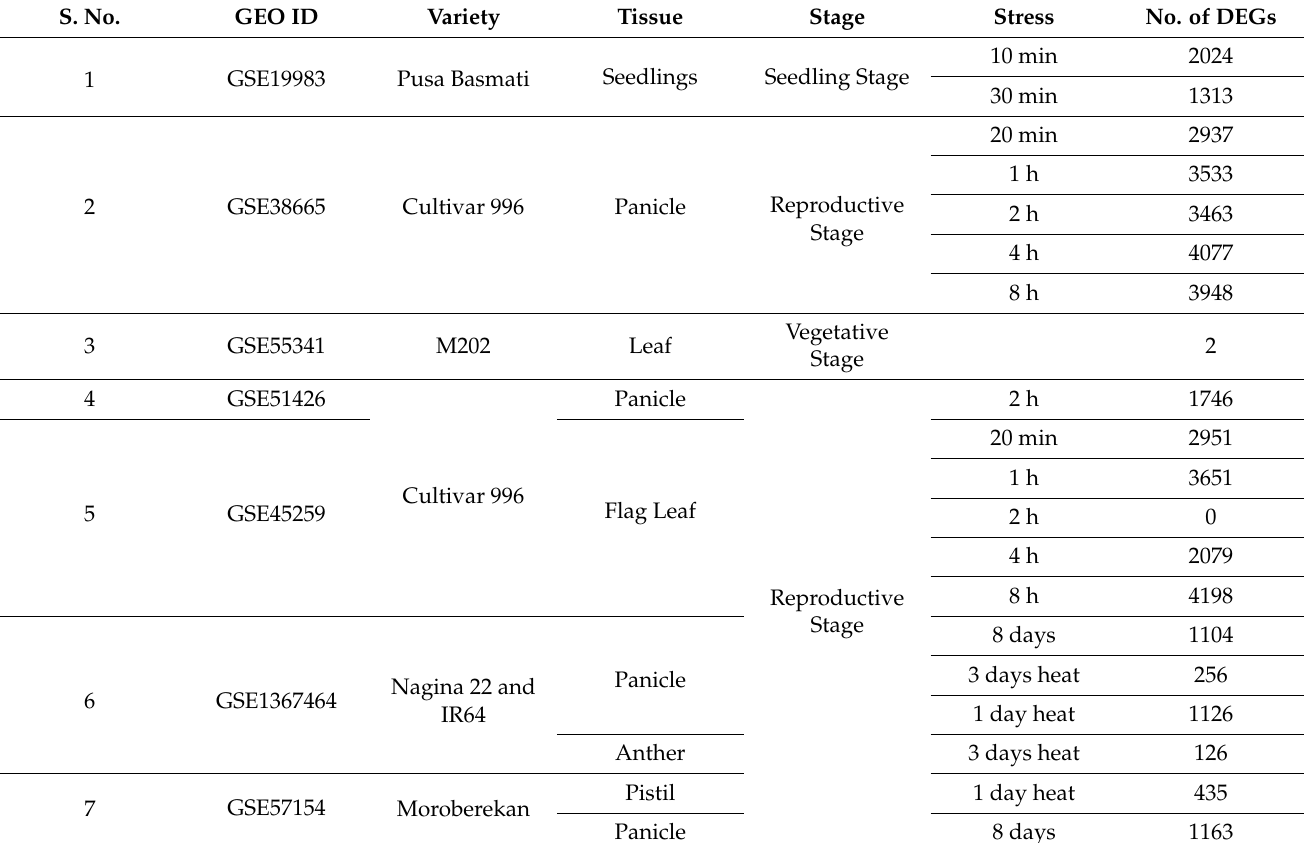
Table 1. Details of the microarray datasets used for the identification of heat stress-responsive genes in